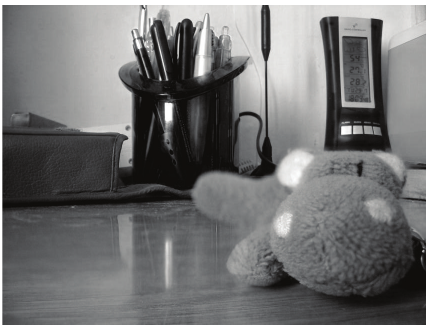
Figure 7: Example of “ghost”—the white area around the left button (a) and the doubled edge of the roof